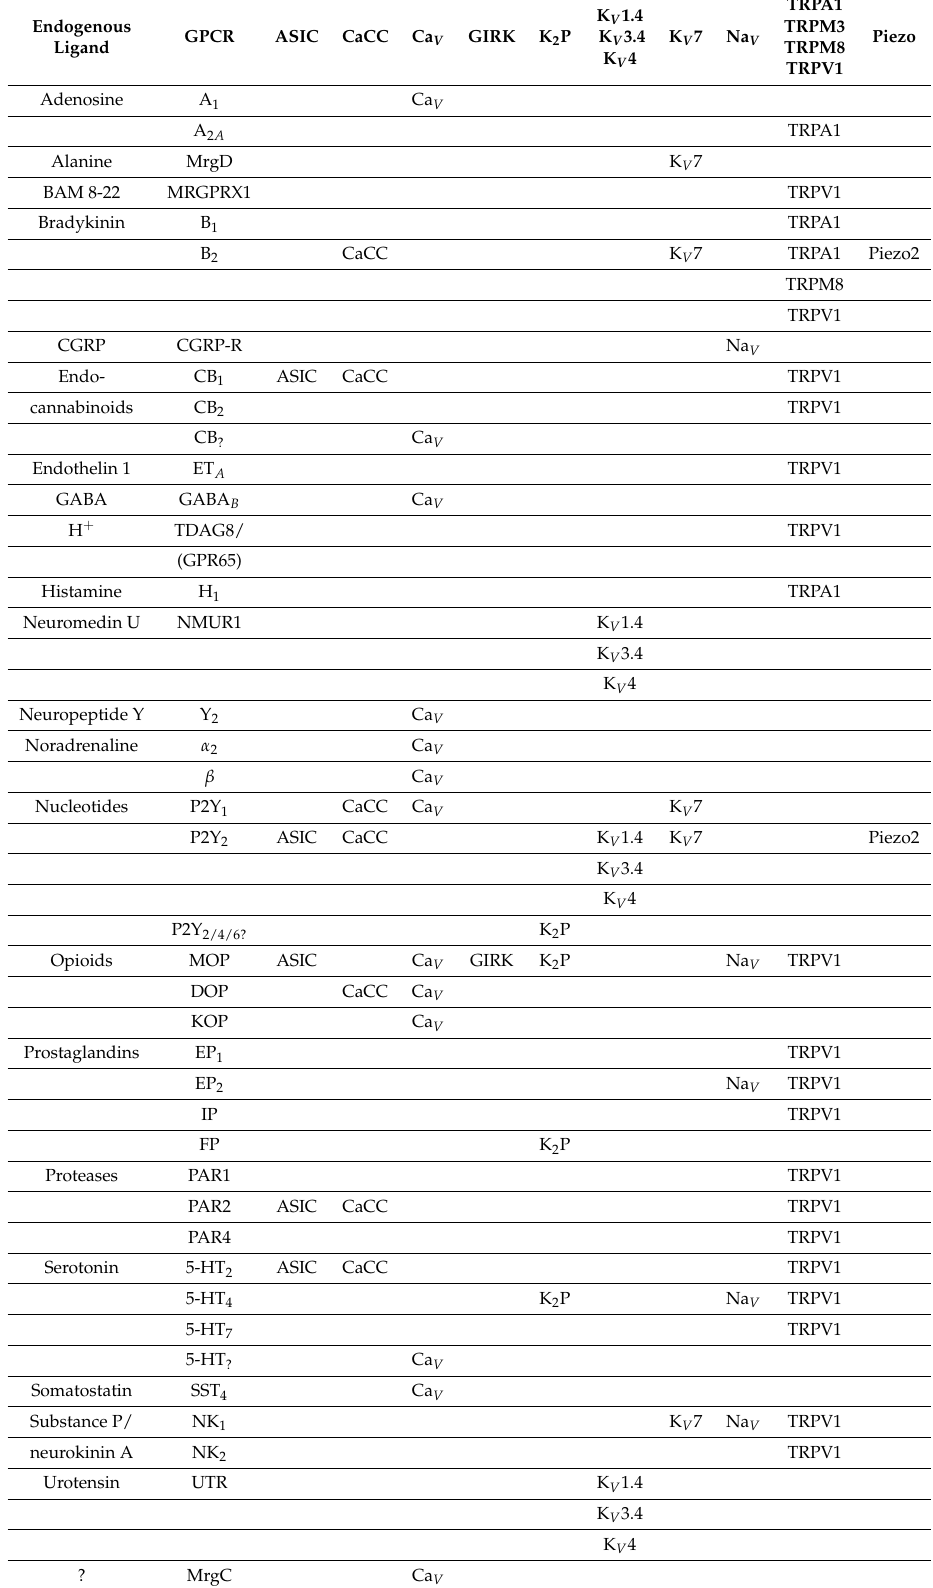
Table 2. Endogenous ligands for GPCRs modulating ion channel